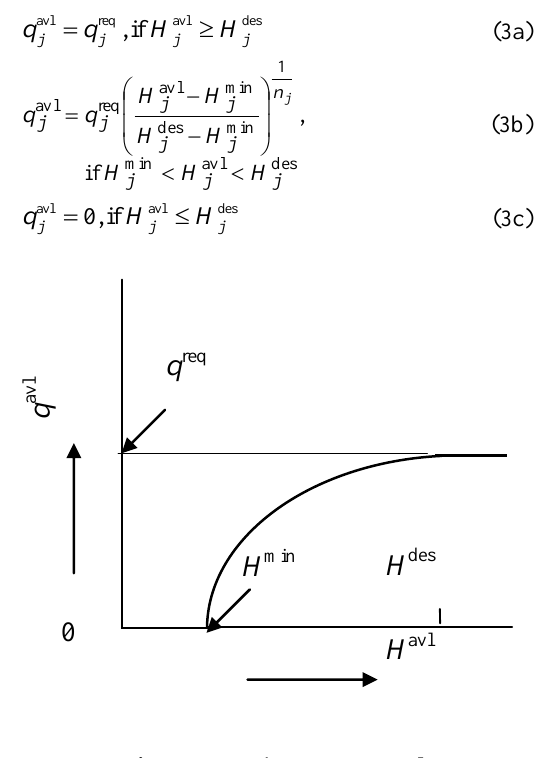
Fig. 2. Germanopoulos’s NHFR.